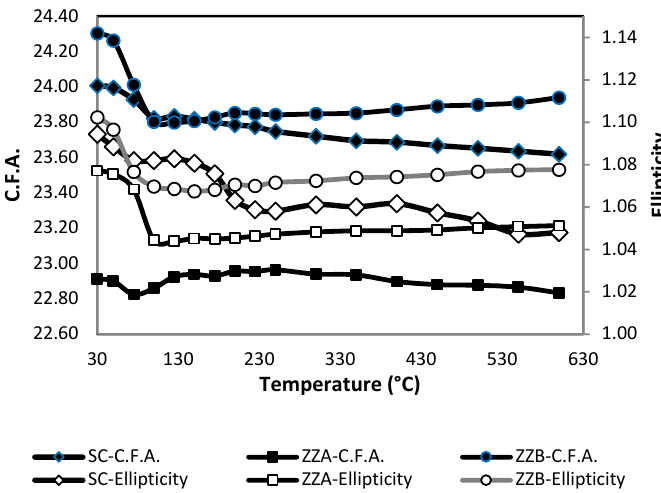
Figure 5. Crystallographic Free Areas (C.F.A.) of the 10-ring channels and ellipticity of the 10-ring channels as a function of temperature. ZZ stands for zigzag or sinusoidal channel; SC stands for straight channel.